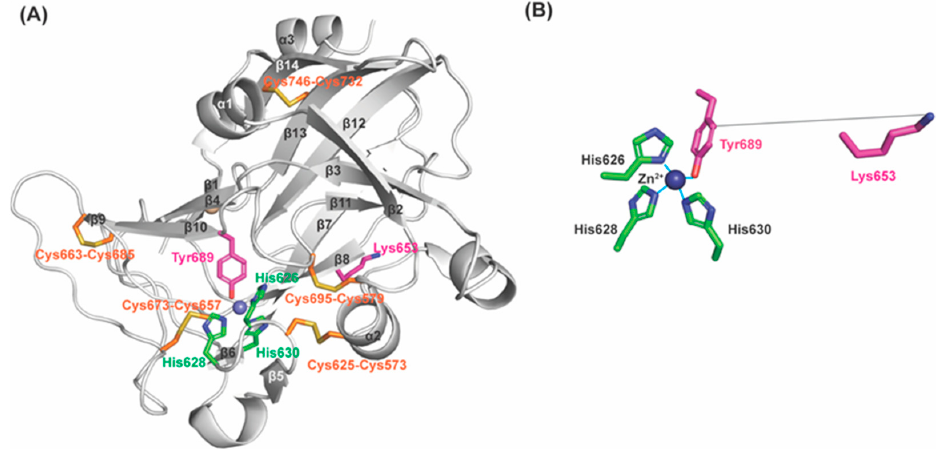
Figure 1. The 2.4 Å structure of a Zn 2+ − bound precursor LOXL2 (PDB: 5ZE3). ( A ) The amine oxidase domain of LOXL2 and precursor residues (Lys653 and Tyr689 in magenta) of the LTQ cofactor and Zn 2+ (navy sphere) occupies the predicted Cu 2+ − binding site, His626 − X − His628 − X − His630 motif (in green). ( B ) Lys653 is located 16.6 Å distance from Tyr689 (in solid grey line). Zn 2+ is in tetrahedral coordination geometry.